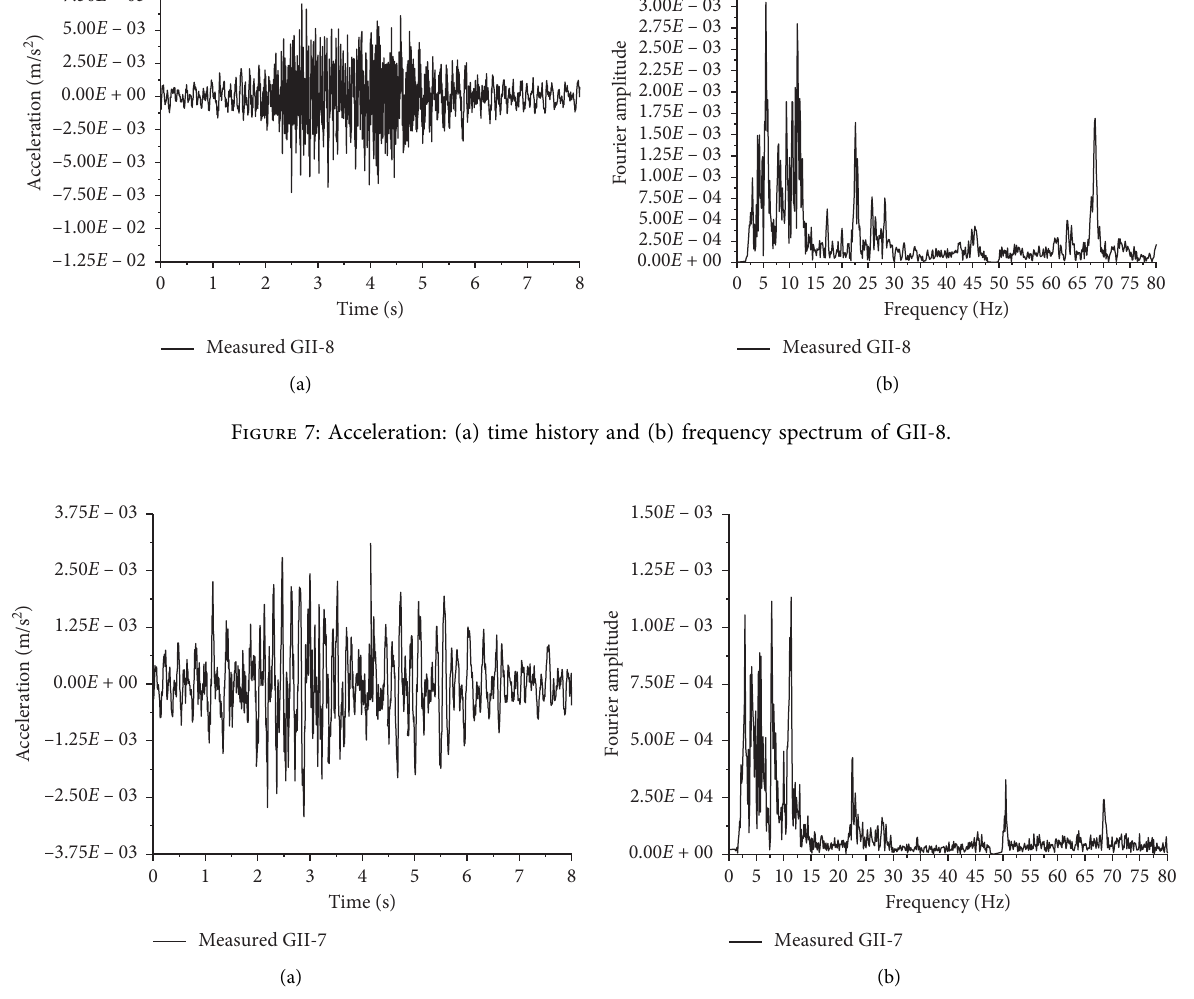
Figure 8: Acceleration: (a) time history and (b) frequency spectrum of GII-7.